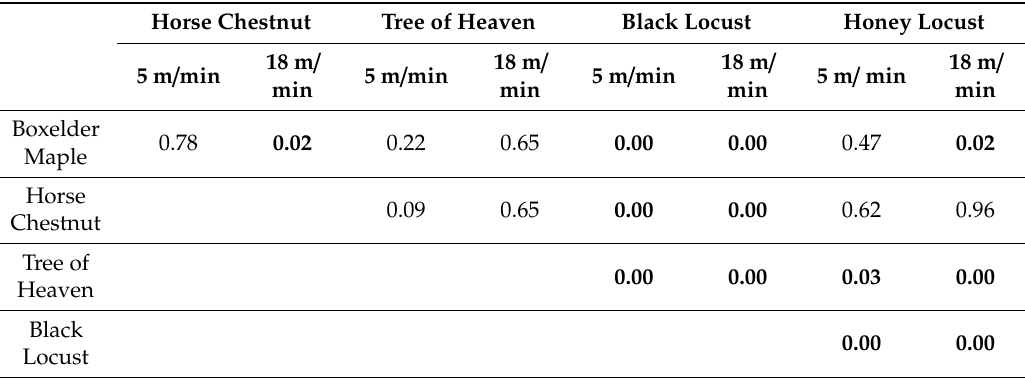
Table 3. Statistical di ff erence of the planing surface quality grades between the tree species at feeding speeds of 5 m / min and 18 m / min expressed by the p -value of the ANOVA analysis. The values in bold indicate a significant di ff erence.